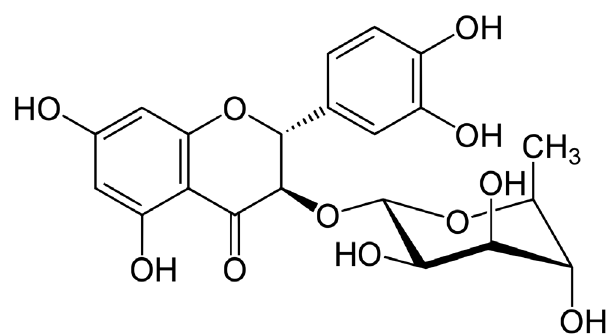
FIGURE 1 - Chemical structure of